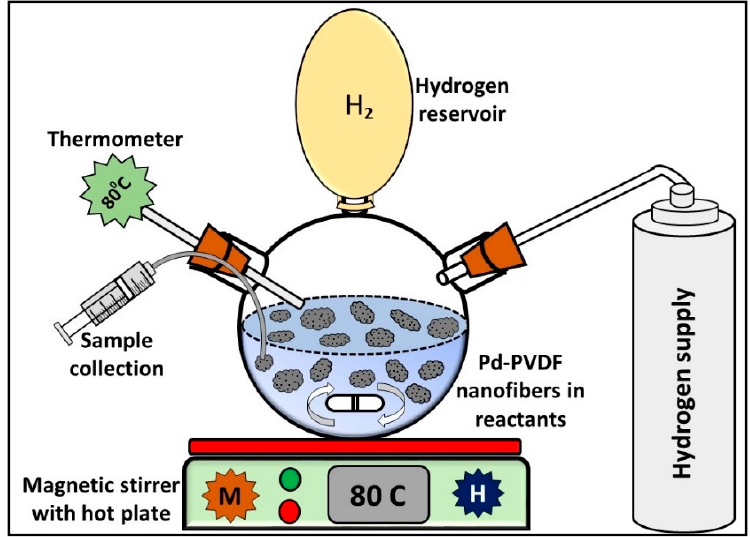
Figure 3. Schematic of batch reactor, not drawn to scale.